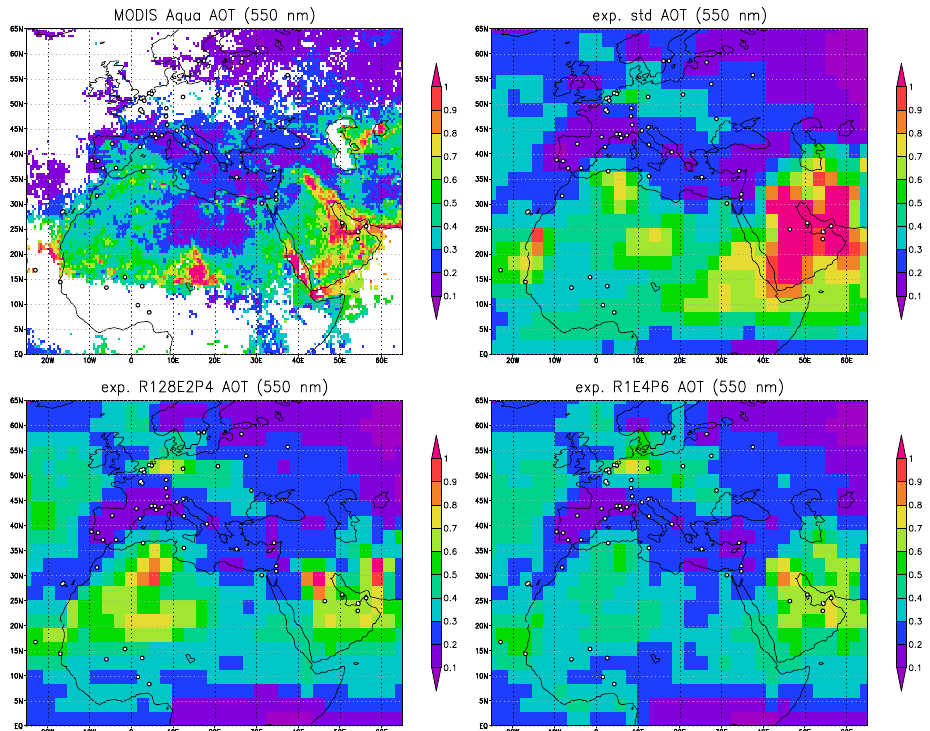
Fig. 20. AOT over Europe & North Africa for MODIS Aqua observations and several experiments.